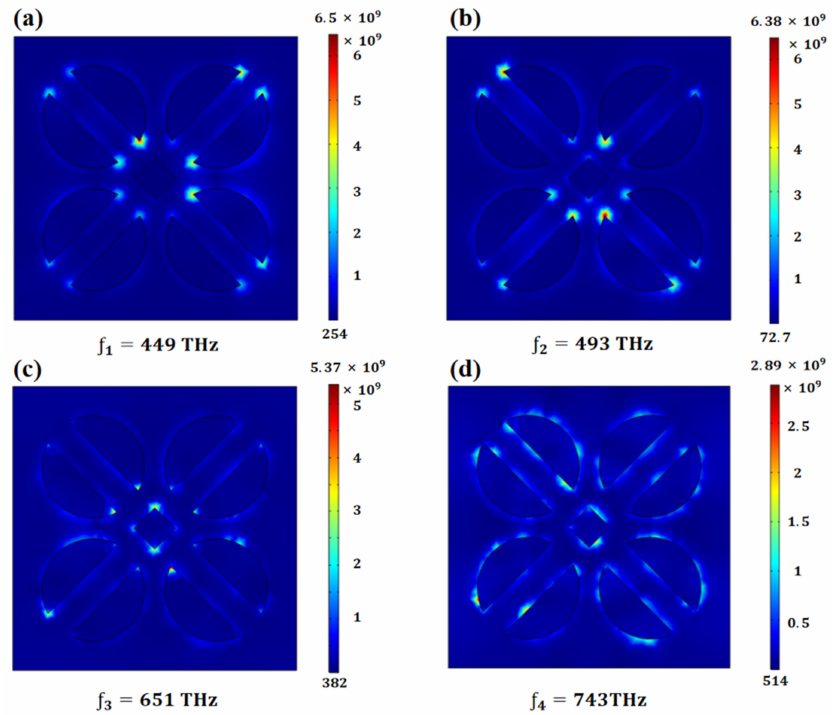
Figure 6. Electric field distribution at the four absorption peaks (E). ( a ) f 1 = 449 THz; ( b ) f 2 = 493 THz; ( c ) f 3 = 651 THz; ( d ) f 4 = 743